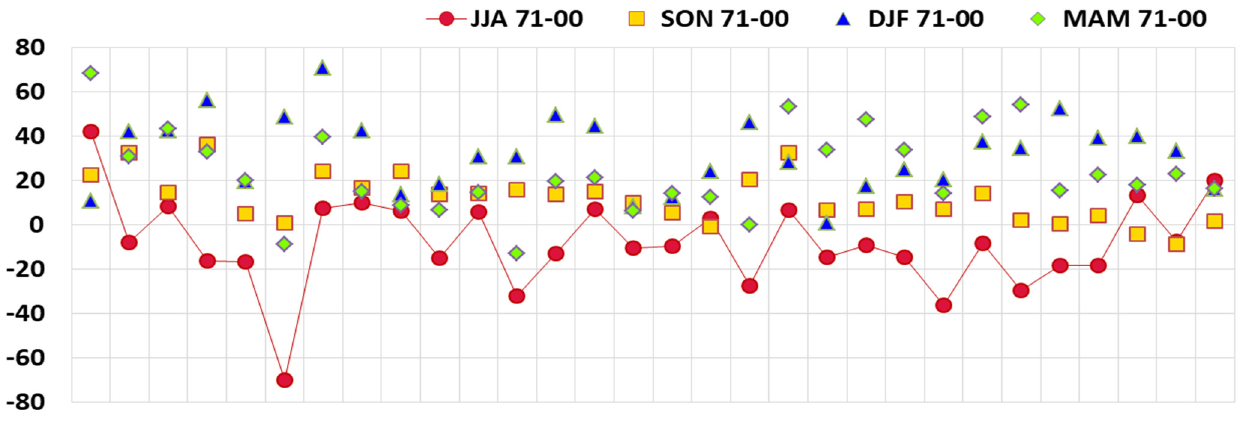
Figure 6. Mean (1971–2000) GCM–RCM seasonal bias of the mean temperature field averaged over the Pannonian Basin and compared with the E-OBS gridded dataset. The red line denotes overall bias during the summer. Units are in °C. The integration numbers follow the list from Table 1.